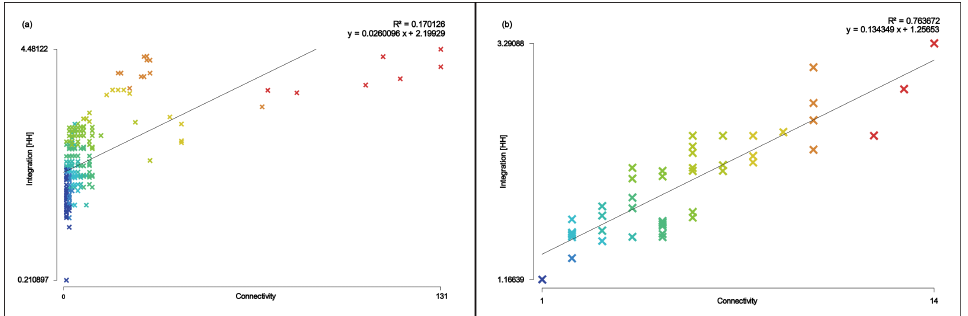
Figure 10. ( a ) Intelligibility of Chang’an of the Tang Dynasty and ( b ) intelligibility of Dongjing of the Northern Song Dynasty.